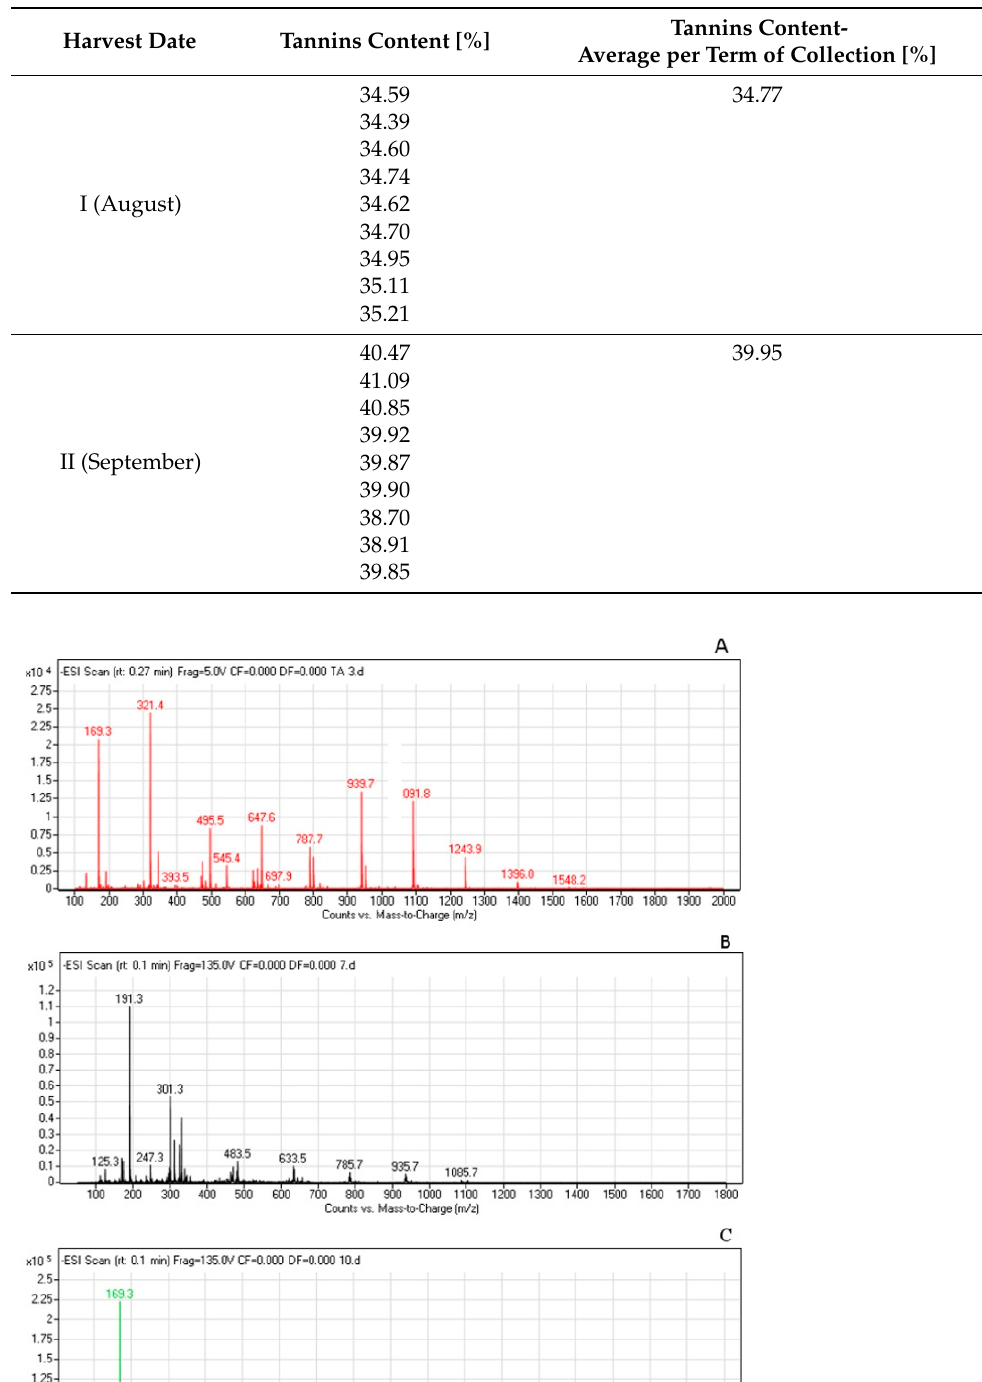
Table 3. Content of tannins in Andricus infectorius gall nuts.